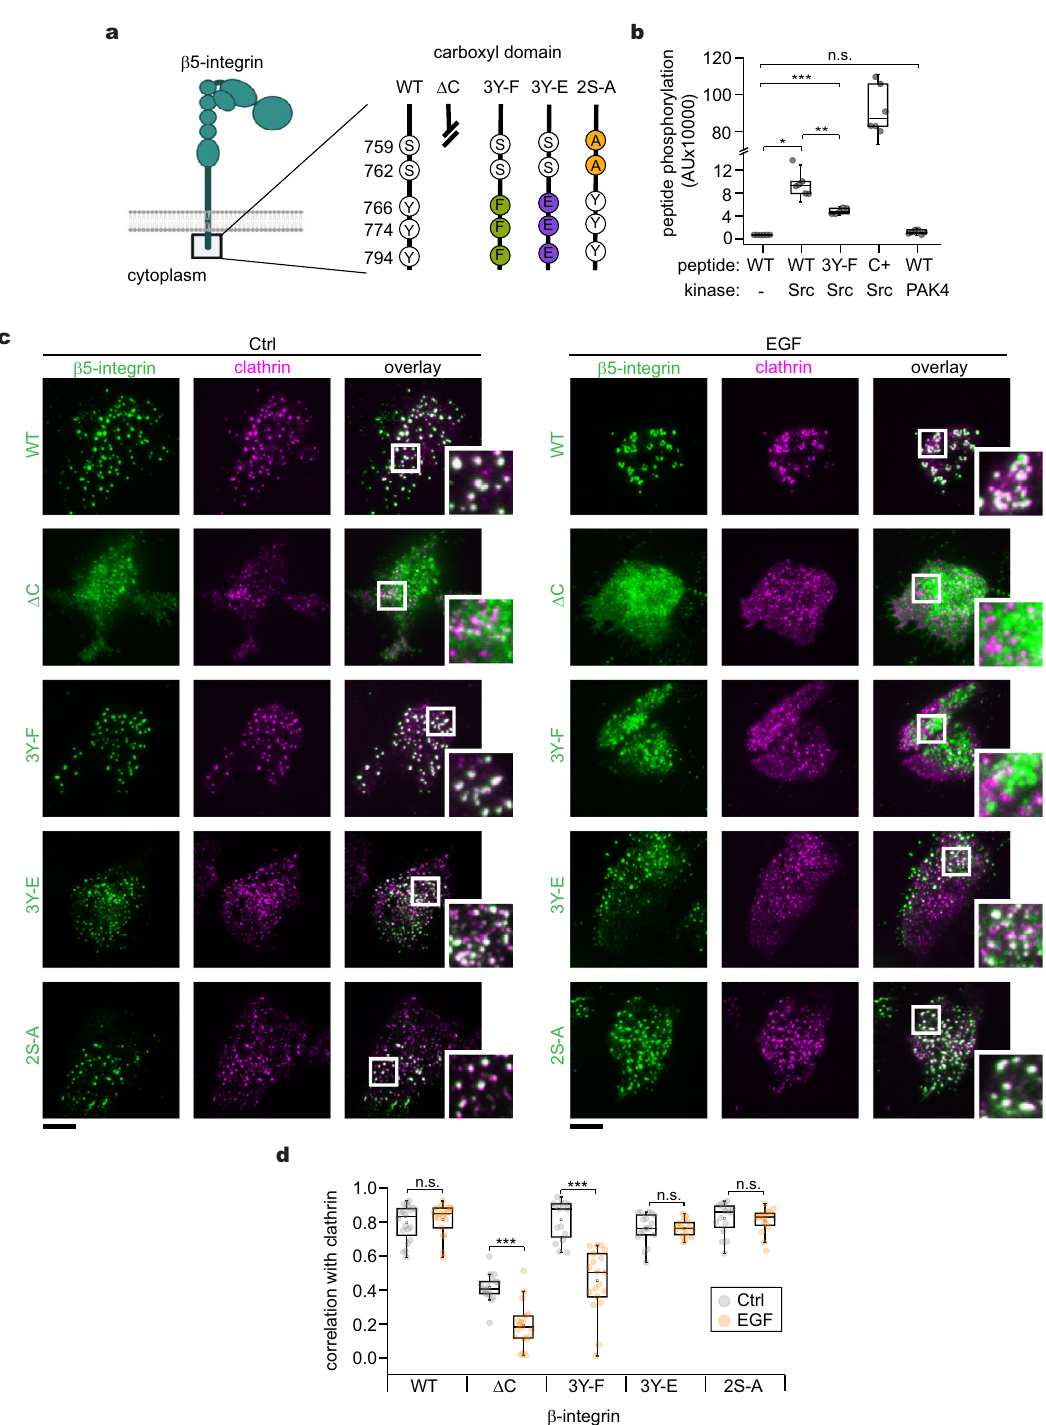
were lysed with 200 μ L of RIPA buffer (Thermo Scienti fi c, 89900) supplemented with 5 mM EDTA, and 1X protease inhibitor (Thermo Scienti fi c, 87786) for 1h on ice. Lysates were centrifuged at 12,000× g for 15 min. Proteins in supernatants were quanti fi ed using the Pierce BSA protein assay kit (Thermo Scienti fi c, 23227) and separated by SDS-PAGE. Then, samples were electrotransferred onto poly- vinylidene di fl uoride membranes. Immunoblotting was performed using the fol- lowing dilutions of primary antibodies and secondary antibodies: 1:8000 EGFR (D38B1) rabbit mAb (Cell Signaling, 4267); 1:4000 β 5-integrin (D24A5) rabbit mAb (Cell Signaling, 3629); 1:4000 Src (14H2L20) rabbit mAb (Thermo Scienti fi c, 701396); 1:5000 GAPDH (D16H11) rabbit mAb (HRP conjugated) (Cell Signaling, 8884); 1:30,000 IgG Fraction Monoclonal Mouse Anti-Rabbit IgG (HRP conjugated (Jackson ImmunoResearch, 211-032-171). Chemoluminescence signal was devel- oped using Amersham ECL Prime Western Blotting detection reagents